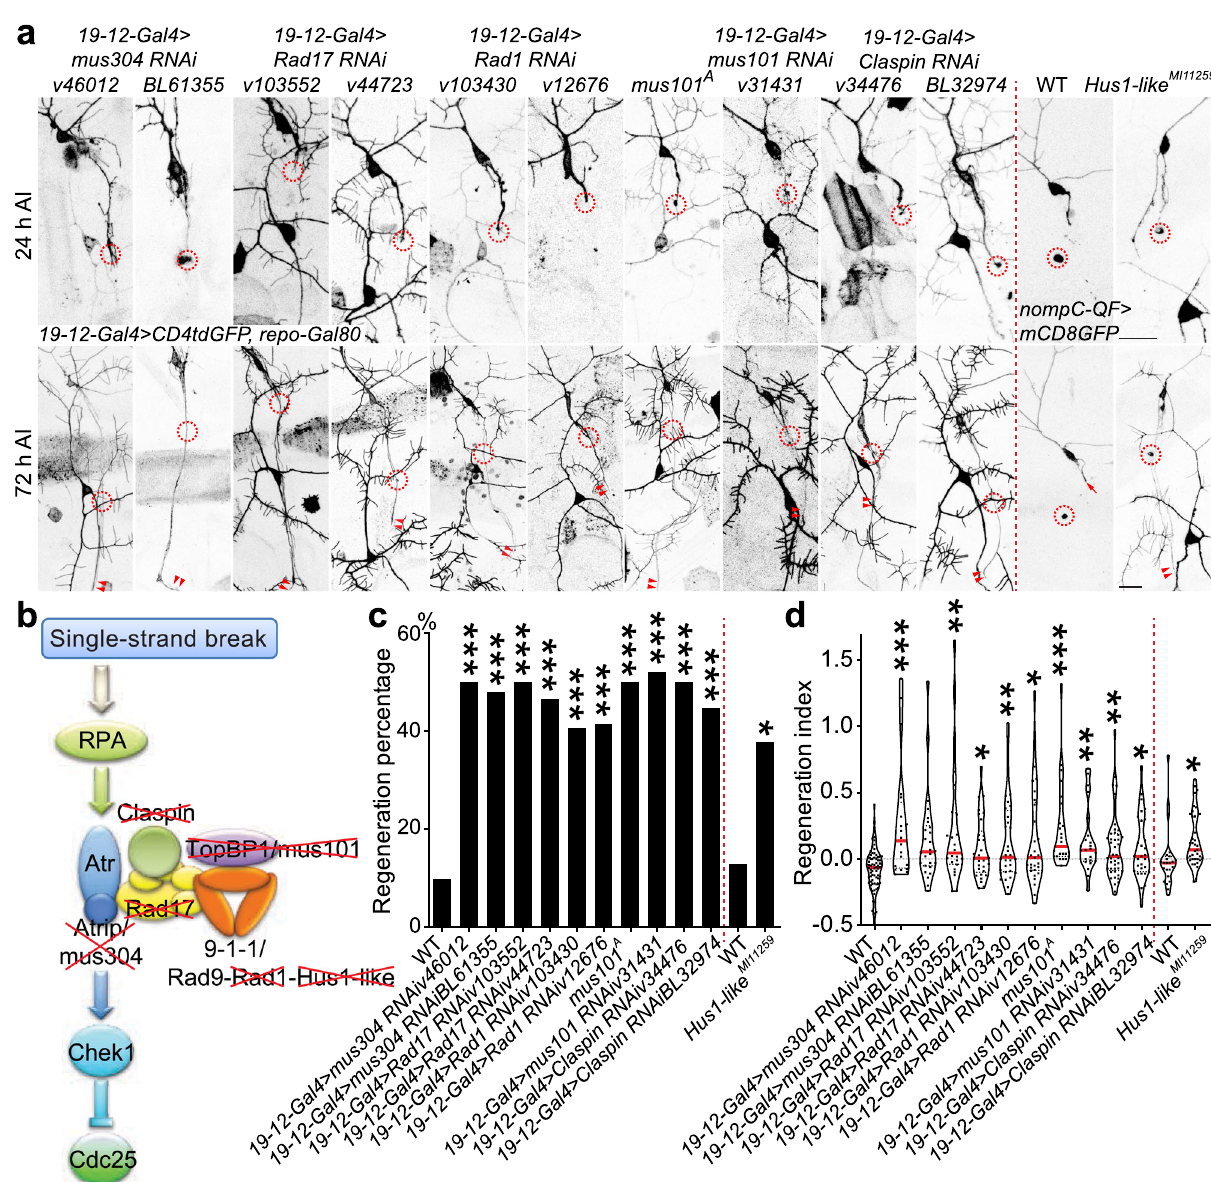
Fig. 3 The Atr-associated checkpoint complex inhibits axon regeneration. a TopBP1/mus101 and Hus1-like mutants, mus101 A and Hus1-like MI11259 , and class III da neuron-speci fi c expression of Atrip/mus304 RNAis, Rad17 RNAis, Rad1 RNAis, TopBP1/mus101 RNAi, or Claspin RNAis increase axon regeneration. The injury site is demarcated by the dashed circle. Arrow marks axon stalling while arrowheads show the regrowing axon tips. b The single- stranded DNA-damage pathway mediated by Atr, Chek1, Cdc25, and the associated checkpoint complex. The factors marked by the red cross are tested for their potential role in axon regeneration. c , d Quanti fi cations of class III da neuron axon regeneration with regeneration percentage ( c ) and regeneration index ( d ). N = 72, 20, 27, 24, 30, 32, 29, 24, 23, 44, 29, 23, and 37 neurons from 6 to 20 larvae. P = 0.0002, <0.0001, <0.0001, <0.0001, 0.0007, 0.0005, <0.0001, <0.0001, <0.0001, 0.0002, 0.0447. * P < 0.05, ** P < 0.01, *** P < 0.001 by two-sided Fisher ’ s exact test ( c ), one-way ANOVA followed by Dunn ’ s test ( d ), two-tailed unpaired Student ’ s t -test ( d , P = 0.0191). Scale bar = 20 μ m. Source data are provided as a Source data fi